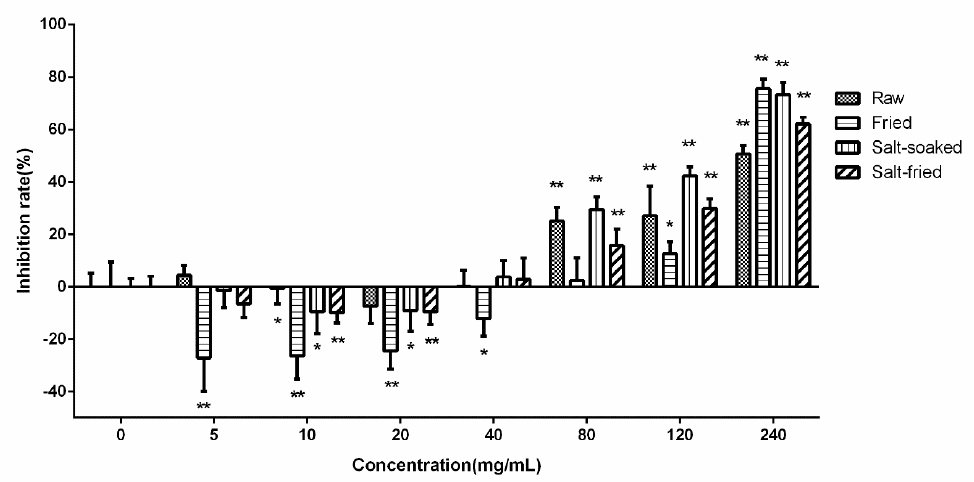
Figure 2. The effects of drug-contained medium with different concentration on Caco-2 cell proliferation activity. Significance: vs. blank medium: * p < 0.05, ** p <